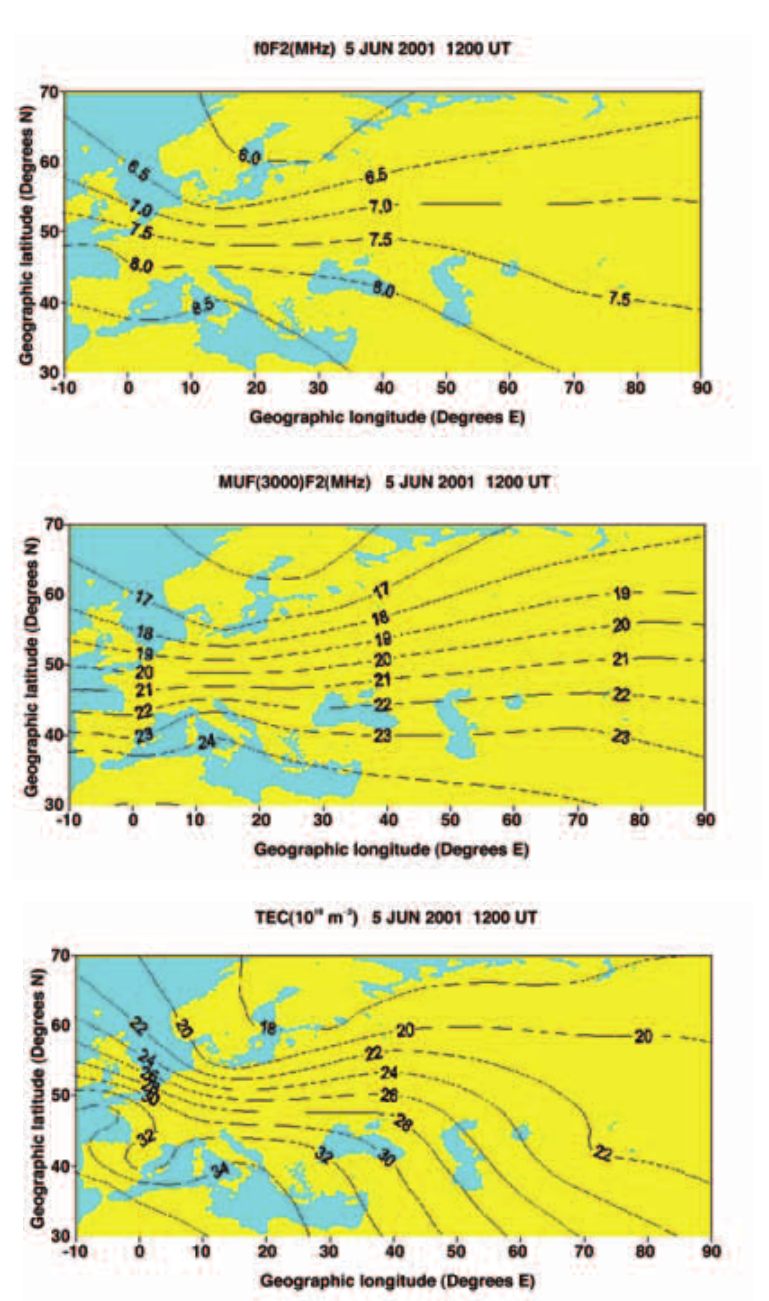
Fig. 1. Maps derived from 24 h ahead forecast of foF 2, MUF(3000) F 2 and TEC for 5 June 2001 at 1200 UT